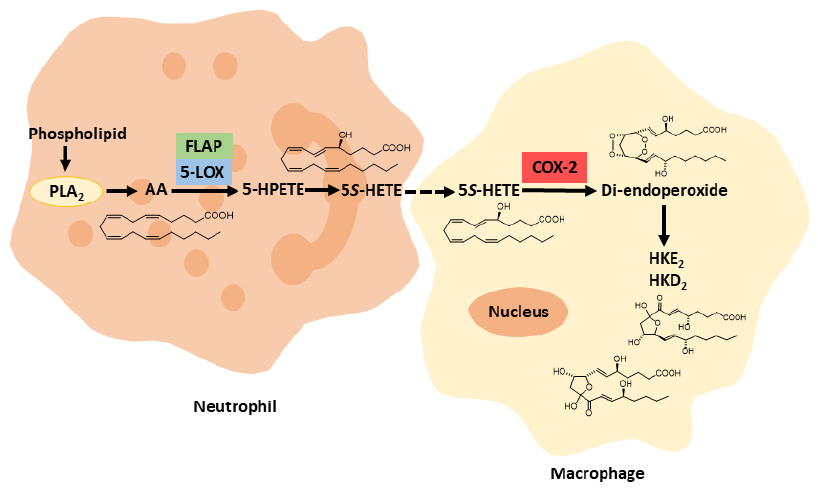
Figure 4. Proposed transcellular biosynthesis of hemiketal eicosanoids .